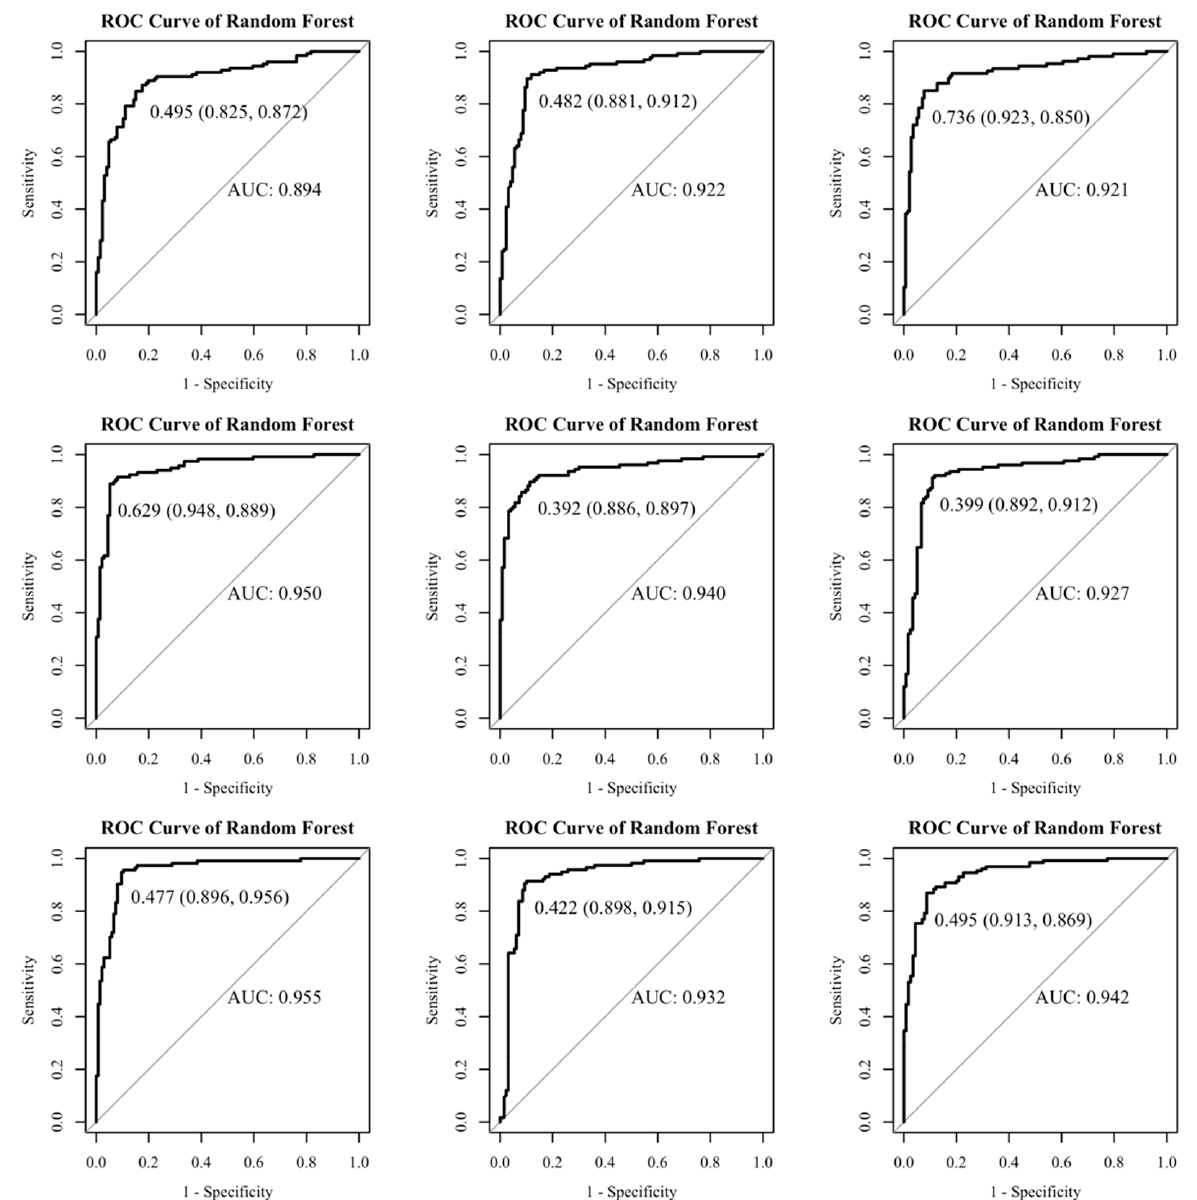
Figure 4. The receiver operating characteristic curve of the three methods. ( a ) shows the ROC curve of the random forest model in predicting macrosomia. ( b ) shows the ROC curve of the logistic re- gression in predicting macrosomia.